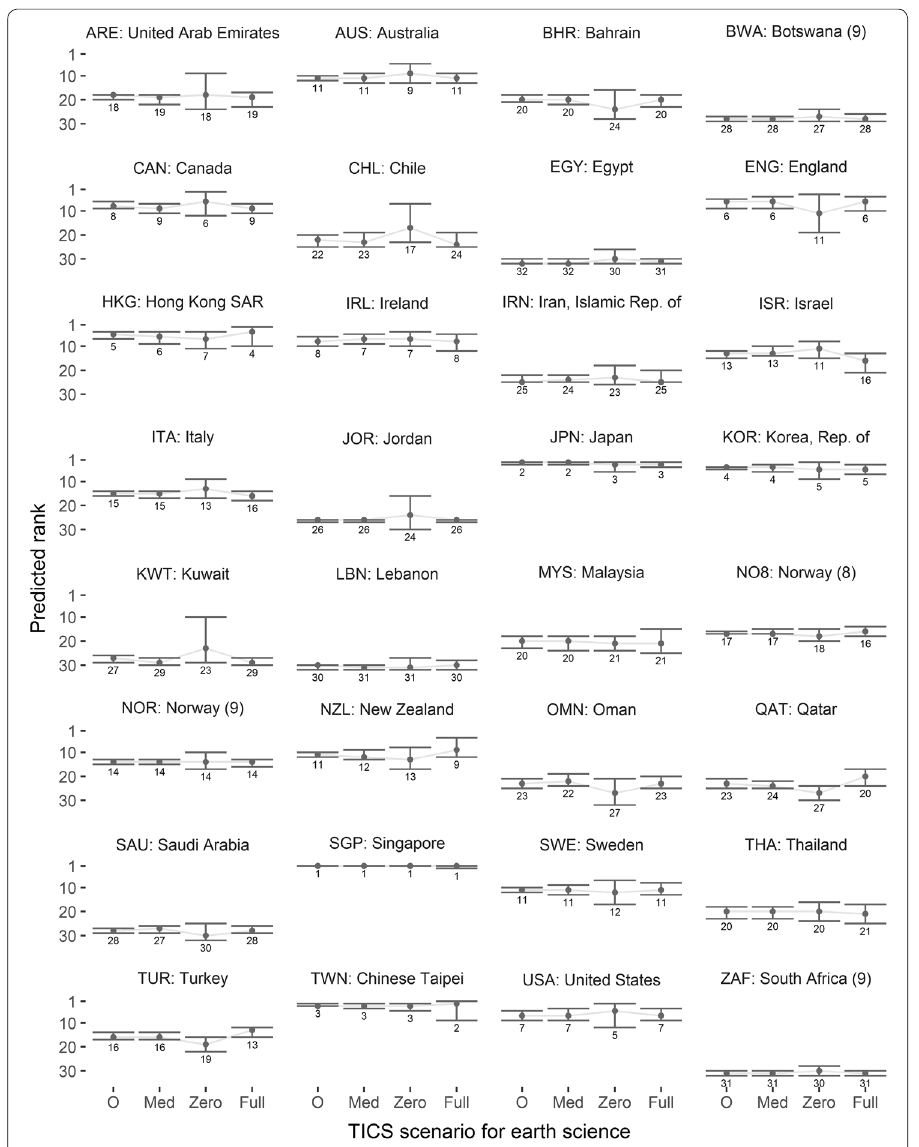
Fig. 16 Predicted rank in earth science across TICS scenarios. O and Full all schools have implemented the country-specific median, the least possible, or most possible = level of TICS within the country, respectively. A blue confidence interval with a downward arrow indicates a significantly lower rank than the original scenario (e.g. Qatar for zero TICS scenario in